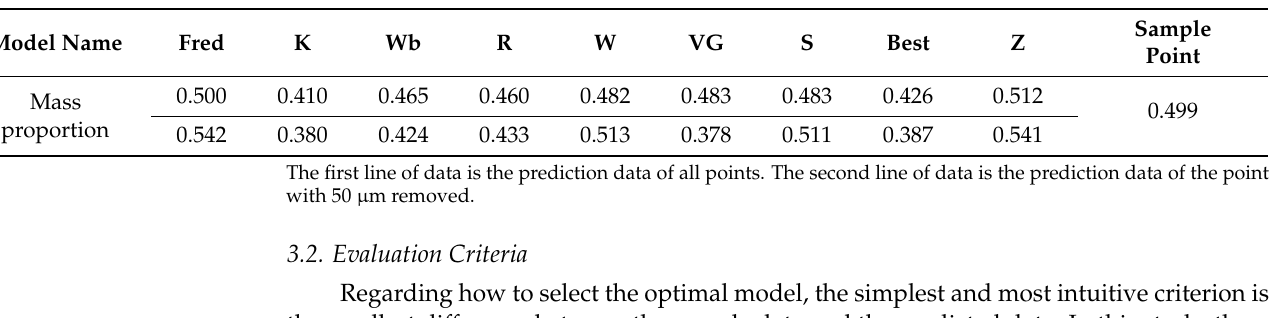
Table 3. Comparison of prediction effects between sample points and non-sample points of each model of soil sample 3010 in UNSODA soil